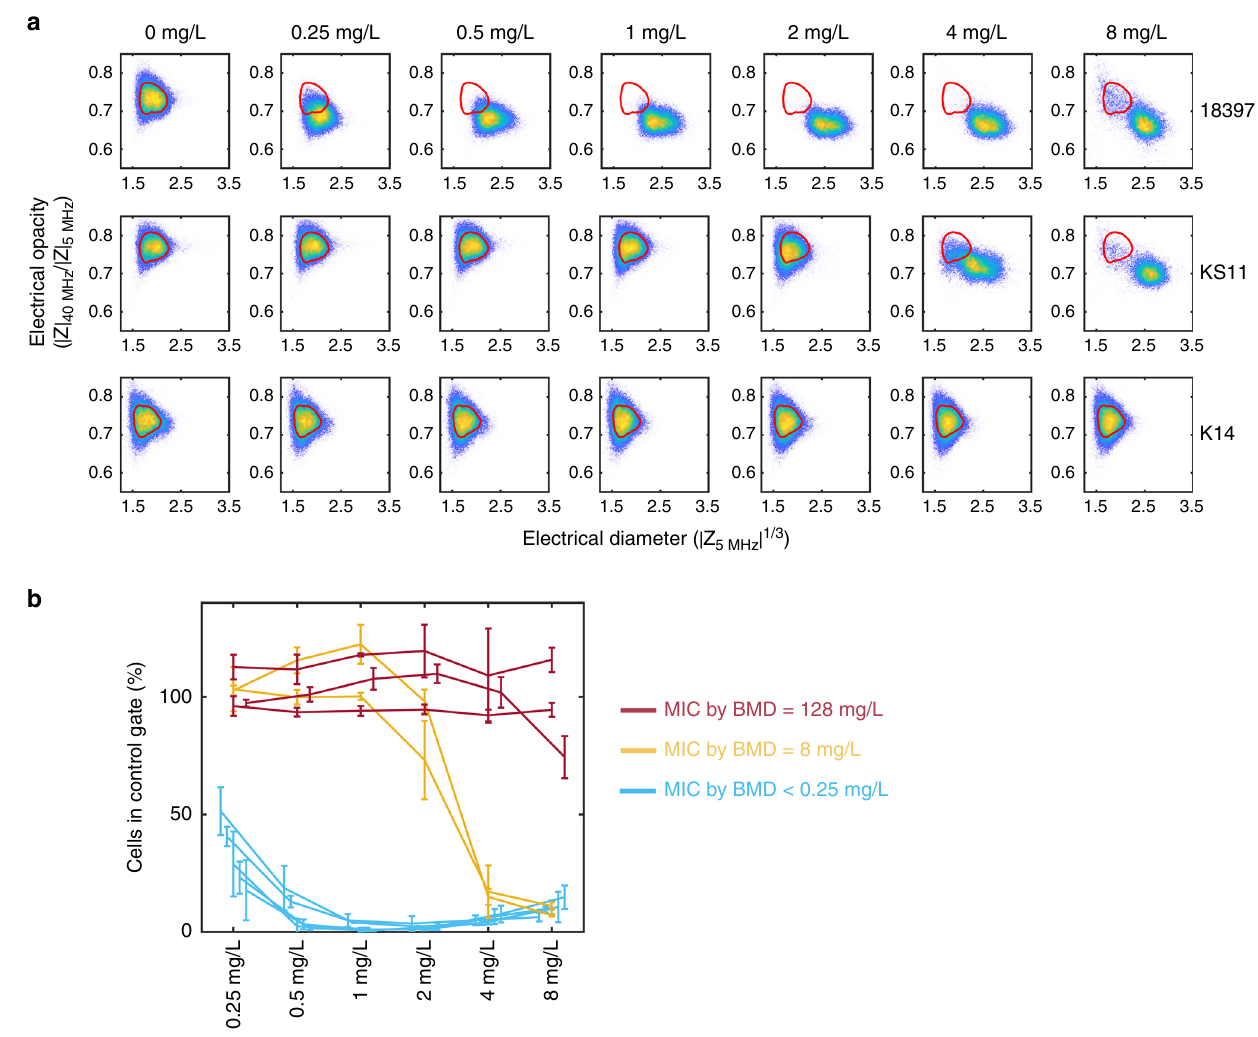
Fig. 3 Electrical minimum inhibitory concentration (MIC). a Scatter plots showing electrical size vs. electrical opacity for three different strains of K. pneumoniae exposed to different concentrations of Meropenem ranging from 0 to 8 mg/L (see Supplementary Fig. 2, protocol 1) Top row: 18397 ( susceptible ), middle row: KS11 ( susceptible, increased exposure ), bottom row: K14 ( resistant ). No changes are observed across all concentrations for K14, whilst a small shift in population is observed for 18397 even at 0.25 mg/L. Broth micro-dilution (BMD) was used (same samples) to measure the MIC and to classify the strains (red = 128 mg/L, orange = 8 mg/L, and blue < 0.25 mg/L). b Electrical MIC for ten different strains of K. pneumoniae that have a range of different MICs (see Supplementary Table 1). The data is plotted as the % cells in a contour (or gate) de fi ned by the unexposed population